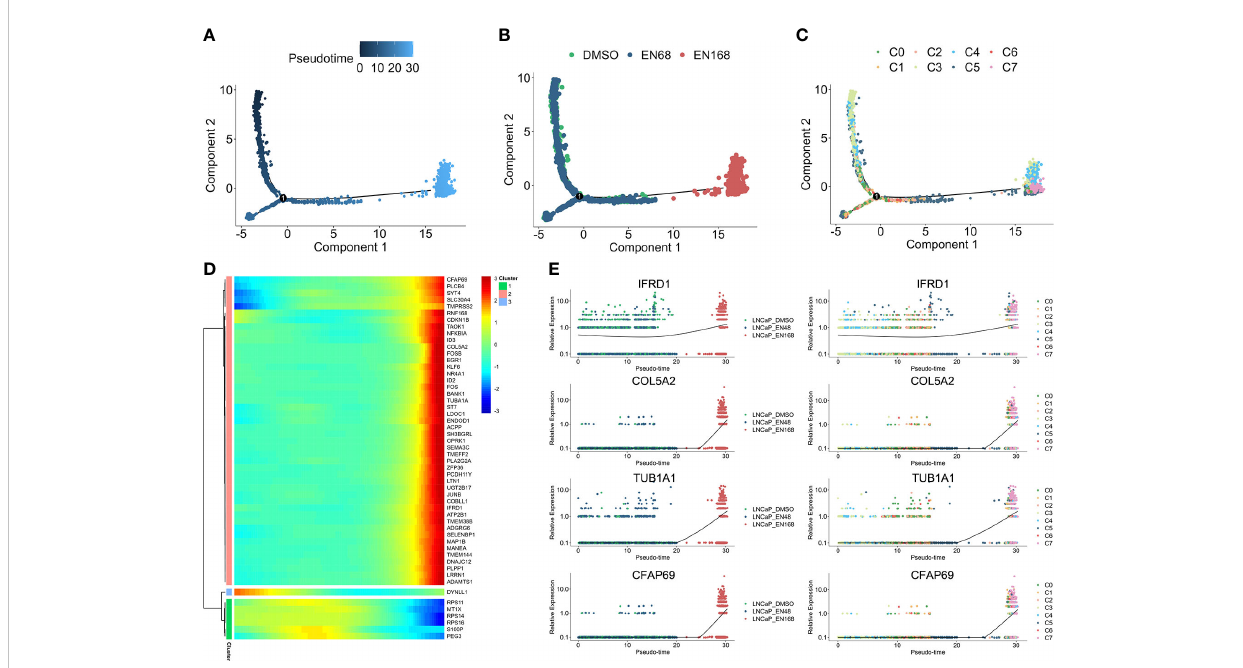
FIGURE 2 The progression trajectory of enzalutamide-induced and pseudo-time gene expression pattern. Pseudo-trajectory (A) , cell type (B) , and cell clusters (C) of enzalutamide-induced cells. (D) Heatmap for expression pattern of genes that induced by enzalutamide-stimulated alone with trajectory- evolved. (E) Expression tendency of representative genes in enzalutamide-induced model and cell